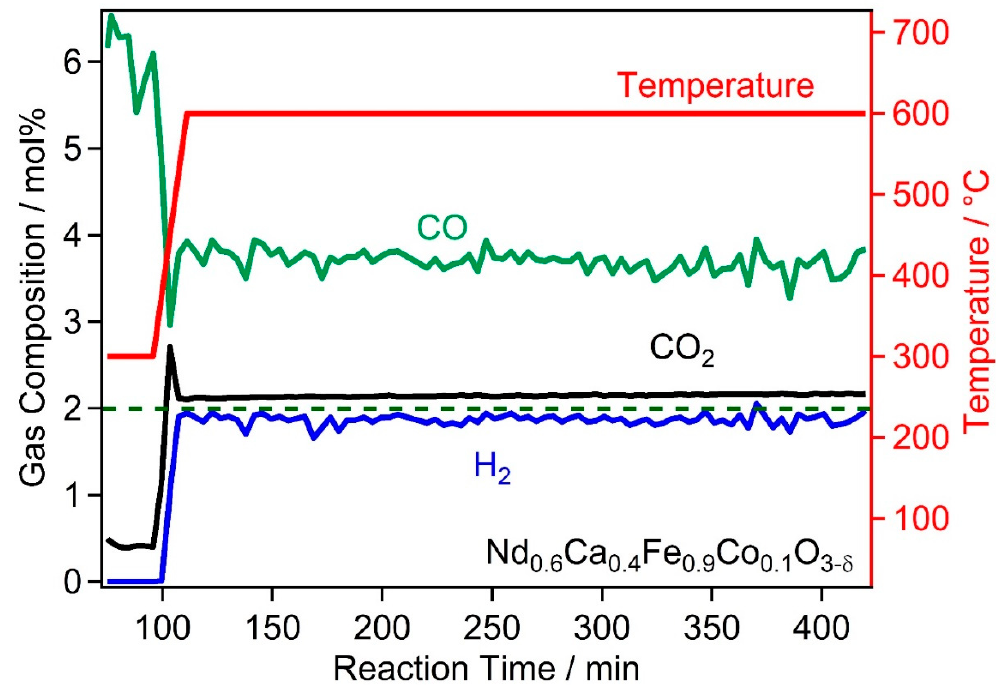
Figure 7. Isothermal HT-WGS reaction at 600 °C for Nd 0.6 Ca 0.4 Fe 0.9 Co 0.1 O 3- δ . The dashed line serves as a horizontal guide for the eye. During the duration of the reaction (about 5 h), the catalyst was slightly increasing its reactivity.